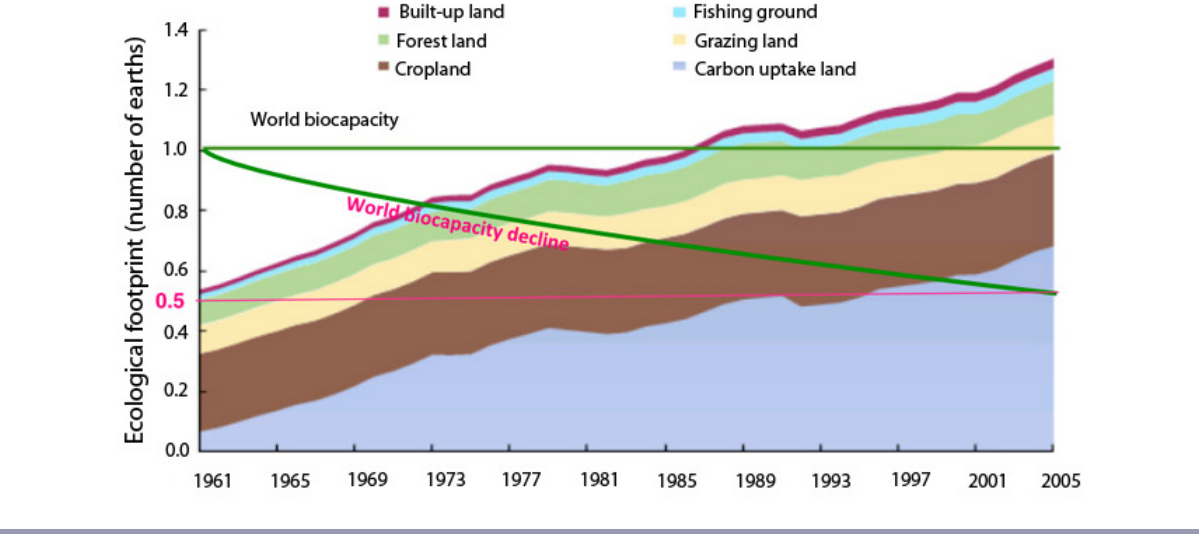
Fig. 1 . The human ecological footprint from 1961 to 2005 (Ewing et al. 2008). The Ecological Footprint is a measure of the demand human activity puts on the biosphere, or Biocapacity (the capacity of an area to provide resources and absorb wastes), in global hectares (ascending red line). In 1986, humanity's consumption began its overshoot with respect to the reference biocapacity of 1961, which has not remained constant but has declined (descending green line), corresponding to its lowered productivity potential relative to its original natural capital. Note that for some commodities the yield (quantity) has remained relatively constant but changed in composition due to technical advances in harvesting that have large unaccounted costs to the